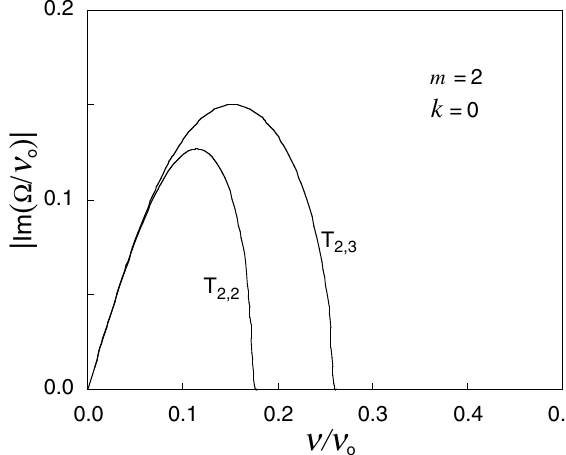
FIG. 9. Absolute value of the imaginary part of (cid:13) =(cid:10) first nine quadrupole modes as a function of (cid:10)=(cid:10) b=a (cid:3) 1 : 5 . Here, only the modes with none-zero Im (cid:1) (cid:13) =(cid:10) labeled. for the first o for k (cid:3) 0 , b=a (cid:3) o